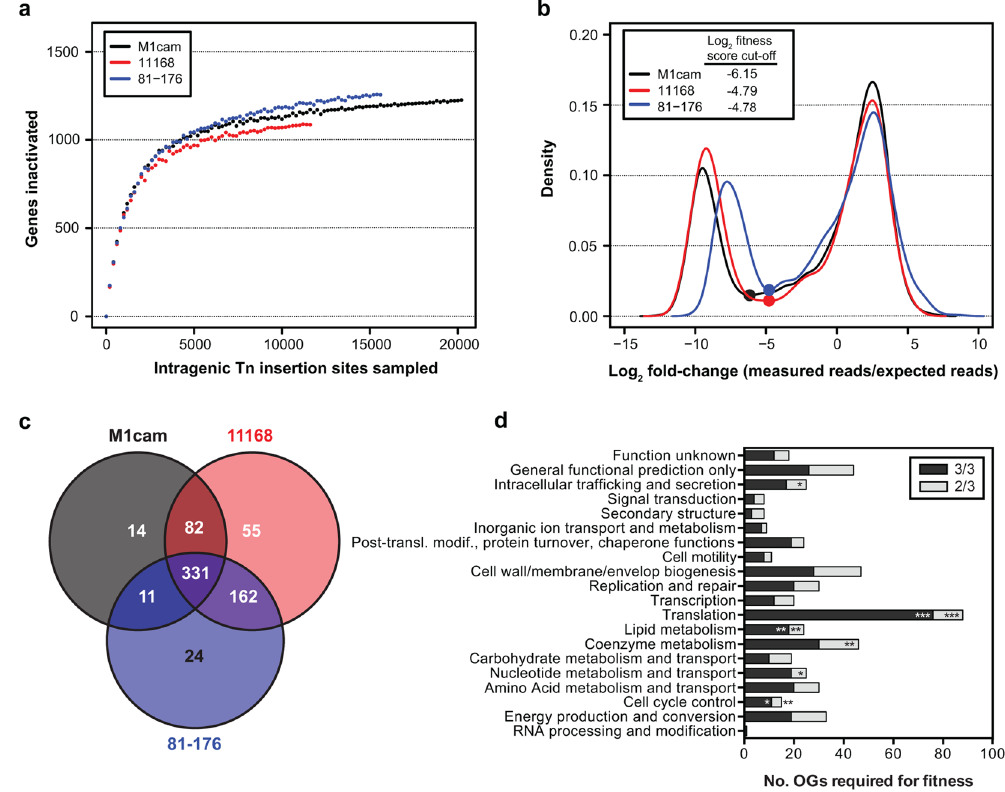
Figure 1. Gene fitness analysis during in vitro growth of C . jejuni M1cam, 11168 and 81–176. ( a ) Rarefaction analysis of intragenic Tn insertions. ( b ) Density plot fitness score (Log 2 fold-change measured reads/expected reads) per gene. Dots indicate fitness score cut-off values. ( c ) Overlap of homologous gene (HG) clusters (HGs) required for fitness in C . jejuni M1cam, 11168, and 81–176, representing the “pan-fitness genome”. HG clusters that are required for fitness in one or more strains are displayed. ( d ) Functional class (COG; Cluster of Orthologous Genes) enrichment analysis of fitness genes. Fisher exact test with Q -value multiple testing correction; * Q < 0.05, ** Q < 0.01 and *** Q <